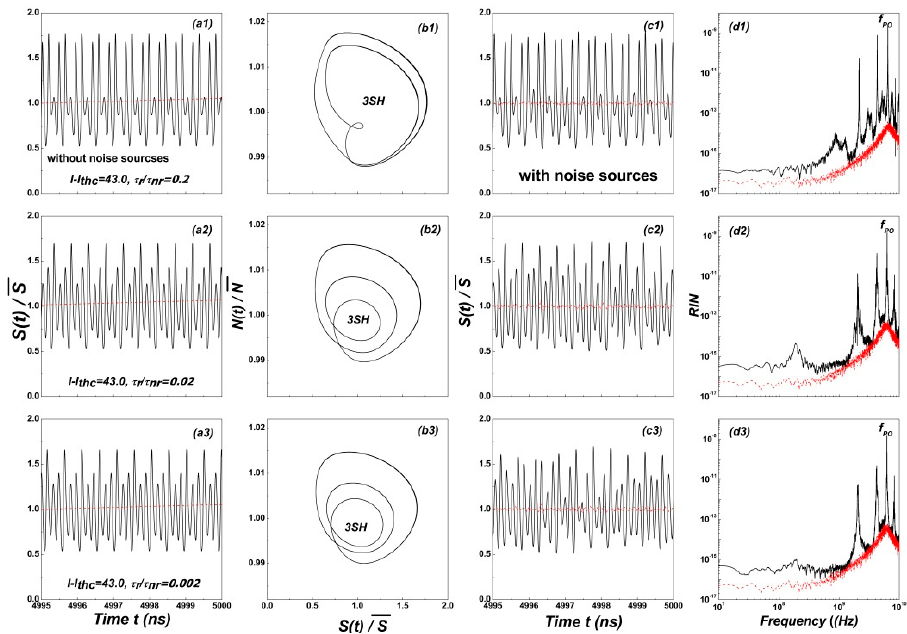
Figure 7. Time, phase portraits, and RIN variations of S ( t )/ S of an SL at route to chaos point, when ( I - I thc ) = 43.0 mA and τ r / τ nr = 2.0, 0.2, 0.02, and 0.002 (second route to chaos).